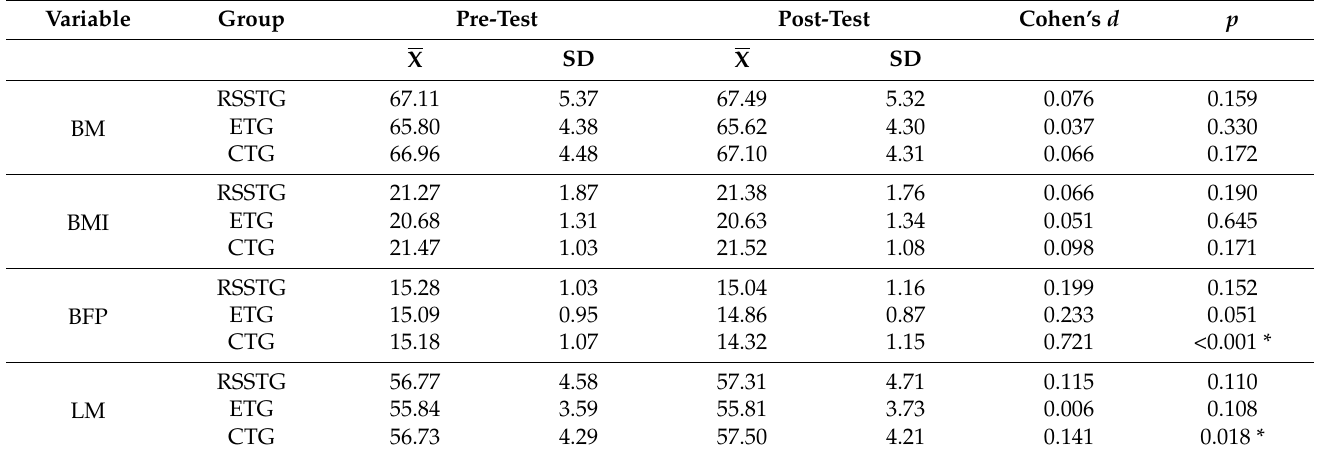
Table 4. Results obtained by the three experimental groups in the pre- and post-test in all the variables